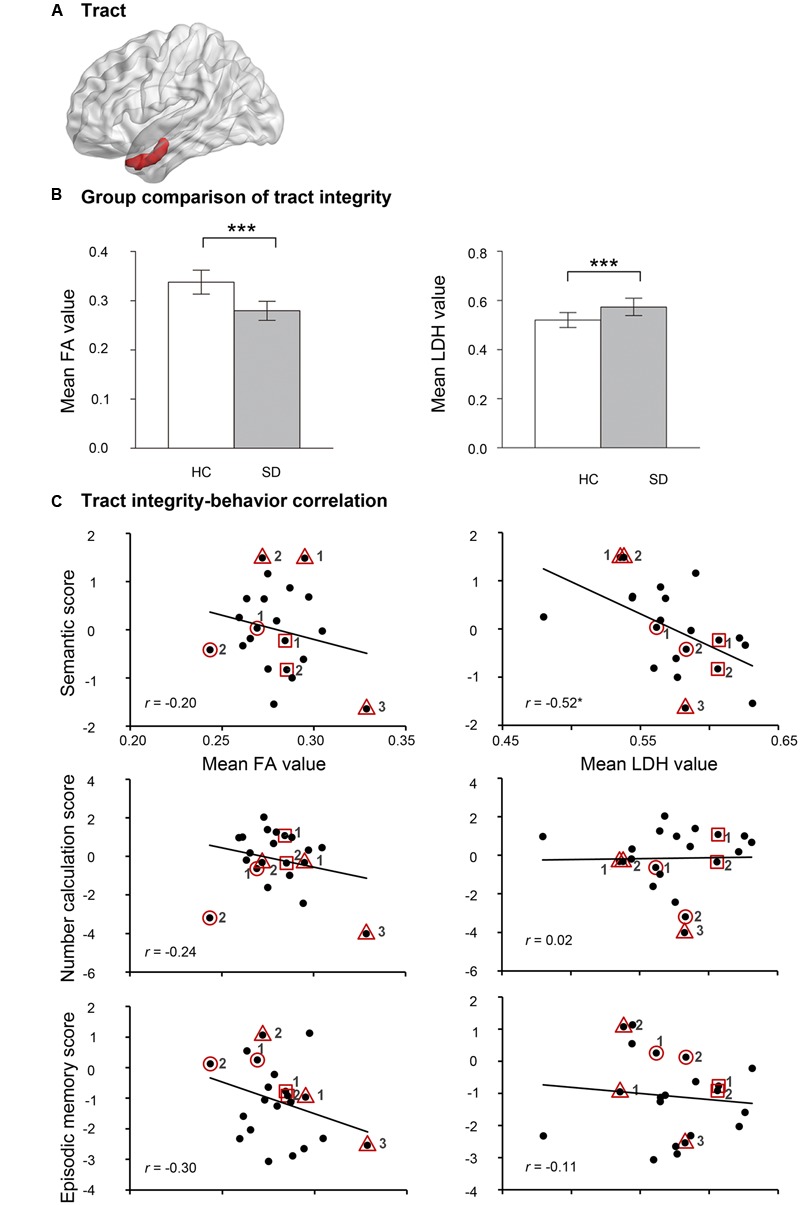
The results of self-obtained white-matter tract connecting the left aHIP to the left TP/INS. (A) Shematic of the self-obtained white-matter tract. (B) Group comparison of FA and LDH in healthy controls and semantic dementia. (C) Correlation between FA and LDH with semantic scores, number calculation scores and episodic memory scores in patients with semantic dementia. ∗p < 0.05, ∗∗∗p < 0.001. Full names of the abbreviations are provided in Table 2. The meaning of the geometric figures and numbers circling the dots see Figure 1.